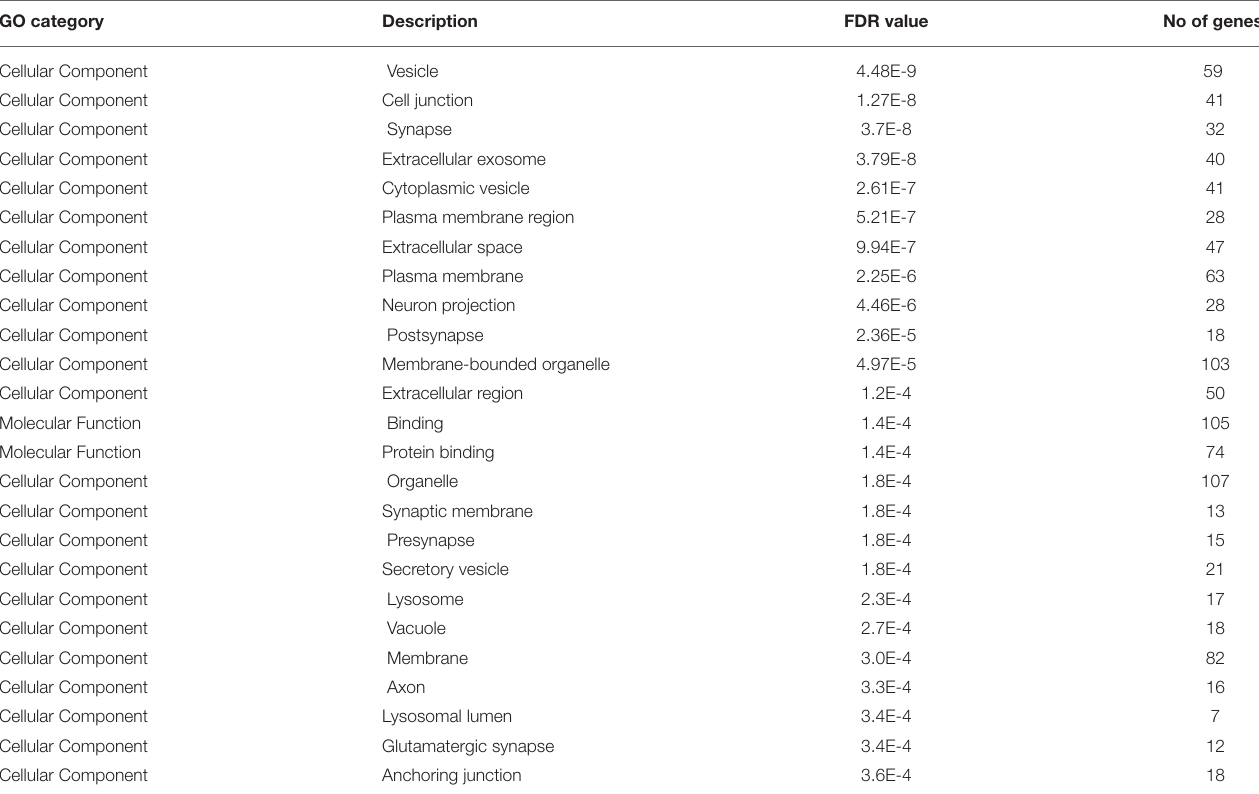
TABLE 7 | Gene ontology (GO) terms with the strongest enrichment in the analysis of the differentially proteins in the comparison between alpha-synuclein-overexpressing and GFP-expressing LUHMES